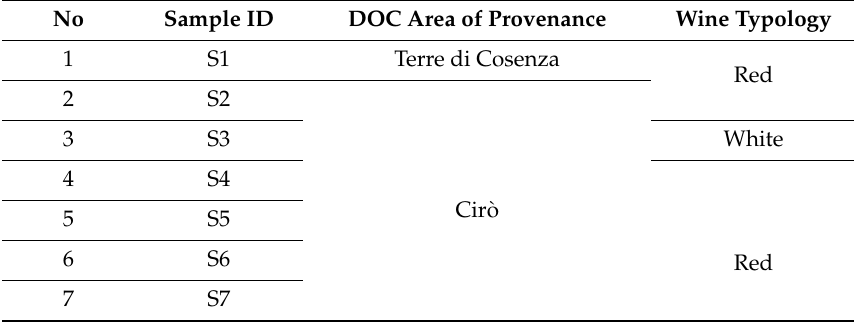
Table 1. Investigated samples together their ID code and geographic area of